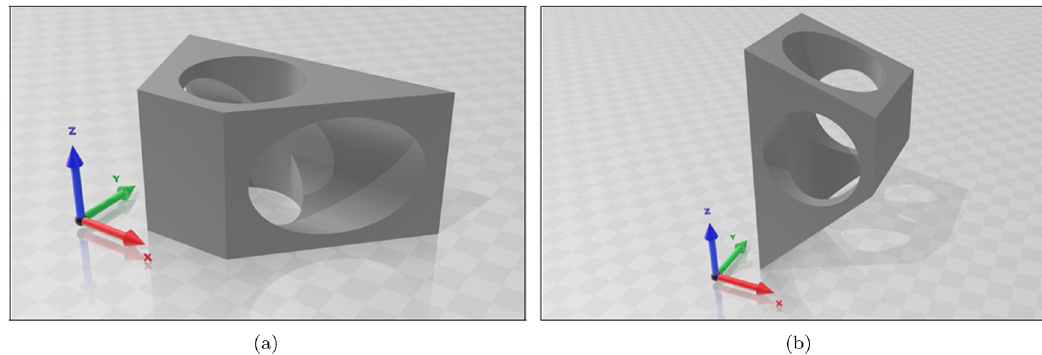
Figure 8: Optimal orientations identi fi ed for case 1. ( a ) Identi fi ed optimum ( 90 , 0 ∘ ∘ ) . ( b ) Second - best orientation ( 0 , 90 ∘ ∘ ) .